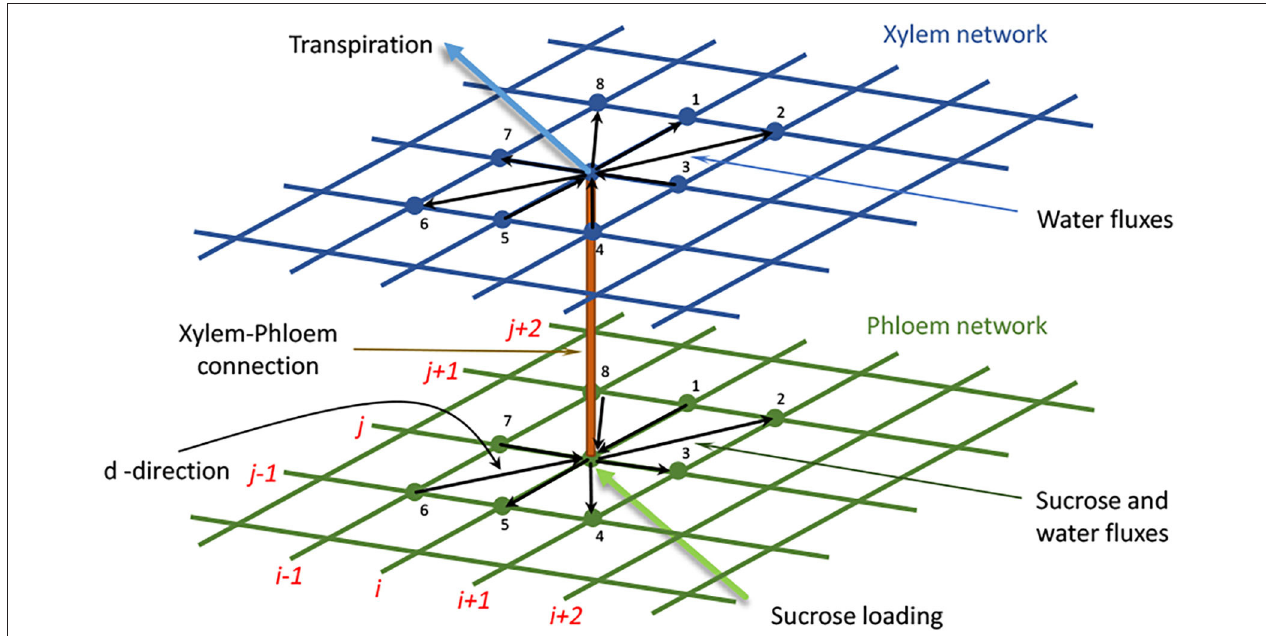
FIGURE 1 | The xylem (upper blue) and phloem (lower green) networks, and their connections. The black arrows indicate the possible flow directions (d) to or from a single node to nearest and next nearest neighbor nodes within each network (these are numbered d = 1 to d = 8). The orange conduit connects a node in the xylem network to its corresponding partner node in the phloem network. The light blue arrow indicates transpiration from a xylem node, while the light green arrow indicates sucrose loading to a phloem node. In the xylem network, only water is transported, while in the phloem network both water and sucrose are transported. In our computations, the nodes are numbered in a grid-like fashion: ( i , j ) = (1,1) ... ( N , M ), as indicated by the red numbering. The identities of nearest and next-nearest neighbor nodes to node ( i , j ) are identified at the leaf creation stage and recorded for later recall.